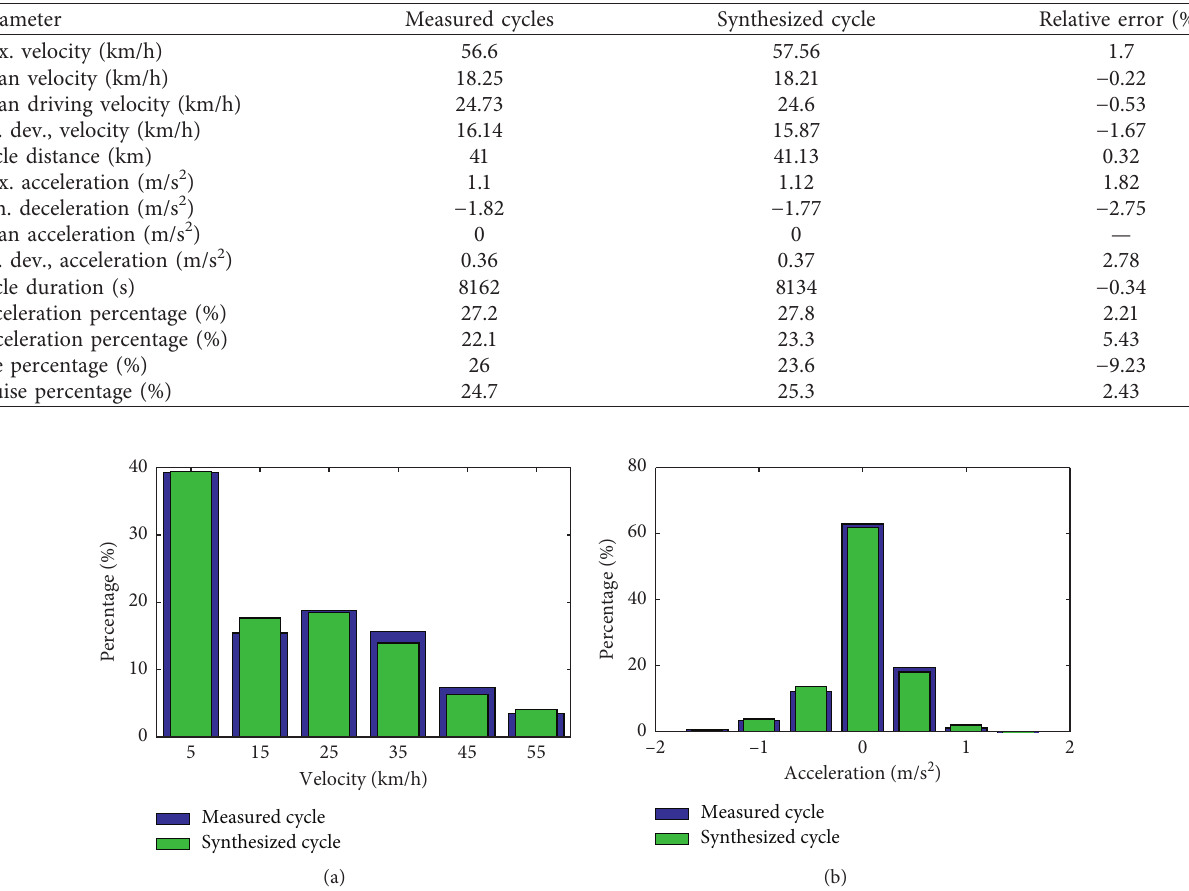
Figure 9: Validation of the matching degree between the synthesized and measured cycle. Distribution of the (a) velocity and (b) the